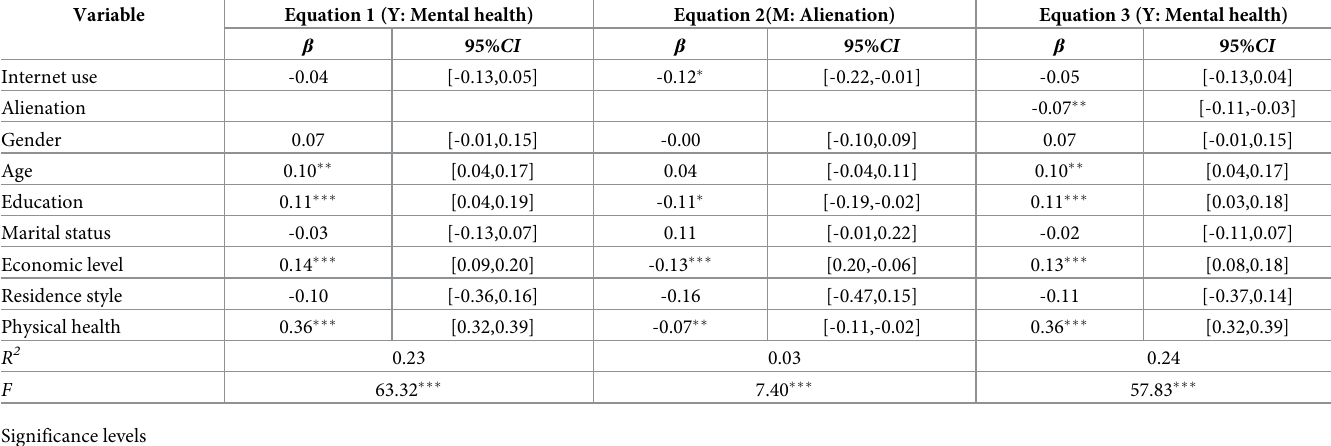
Table 6. Regression results of the relationship among Internet use, alienation and mental health of rural elderly. All variables entered the regression equation after being standardized.